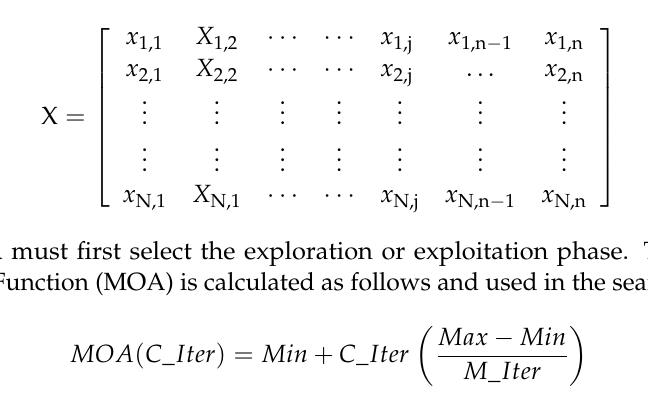
Figure 1. Hierarchy of AOs in AOA with exploration and operation phases adopted from [23].